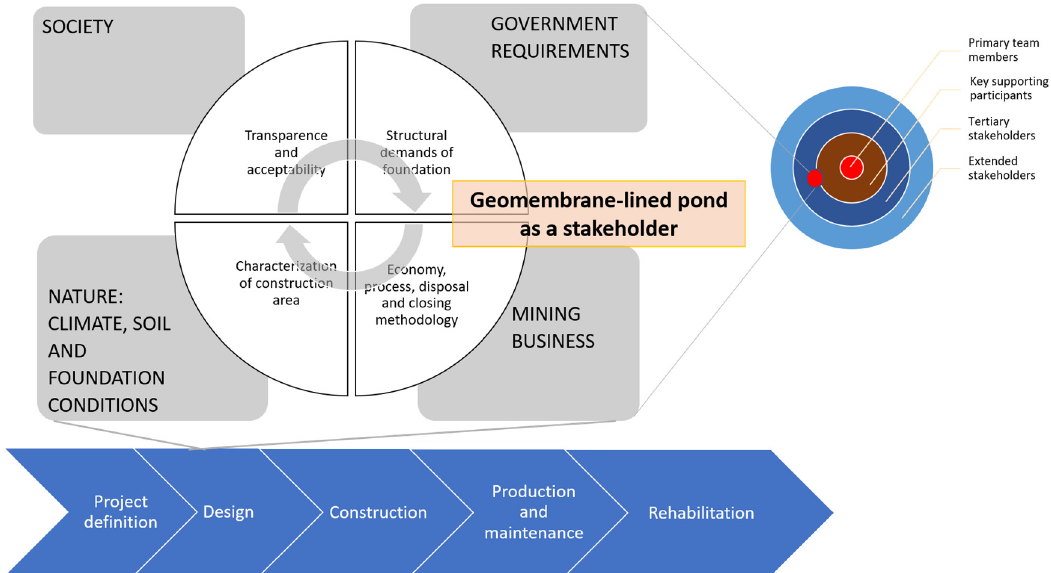
Figure 9. A framework for identified geomembrane-lined tailings pond as a stakeholder in early involvement and integration process. The key supporting perspectives are identified as i) mining business, ii ) governments requirements, iii ) nature, and iv ) society, which all include several details to be noticed in every phase of mining.